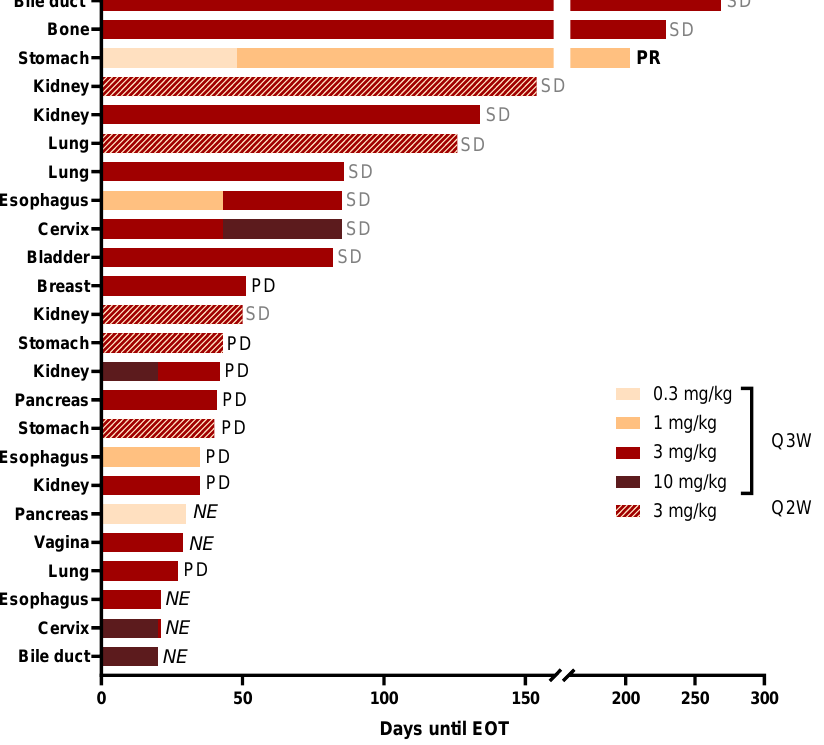
Figure 4. Mean duration of study and best response. Each bar represents one patient and the length of the bar the duration of treatment from until C1D1 end of treatment (EOT). The doses and the administration interval are indicated by the color code. The best response as per investigator review is also indicated on the right for each patient. PR, partial response; SD, stable disease; PD, progressive disease; NE, not evaluable according to RECIST 1.1. Preliminary anti-tumor activity as per RECIST was observed at dose levels 0.3–3 mg/kg. The disease control rate (DCR) was 46% in the DE and SE, with 1/24 partial re- sponse (PR) and 10/24 stable diseases (SDs). In the SE phase, 3/5 patients had SD. Five patients in the DE were not evaluable for response (Figure 4). The best overall response as per investigator review was partial response (PR) in a 49-year old female with gastric cancer who had three prior lines of chemotherapy and total gastrectomy. She had nine measurable lesions in lymph nodes and bone at baseline when she started treatment with 0.3 mg/kg ARGX-111. Before C3, she showed progressive disease with signs of diminished metabolic response in some lesions by PET/CT and was therefore escalated to 1 mg/kg as allowed by protocol. At C4D15, she had another PET/CT which showed that four lesions